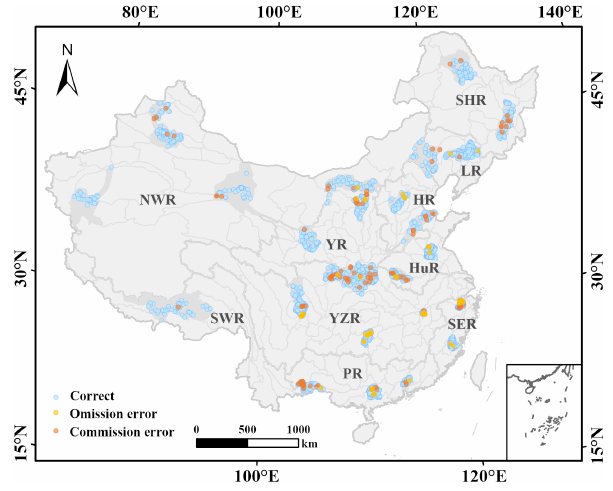
Figure 4. The distribution of all sampled validation